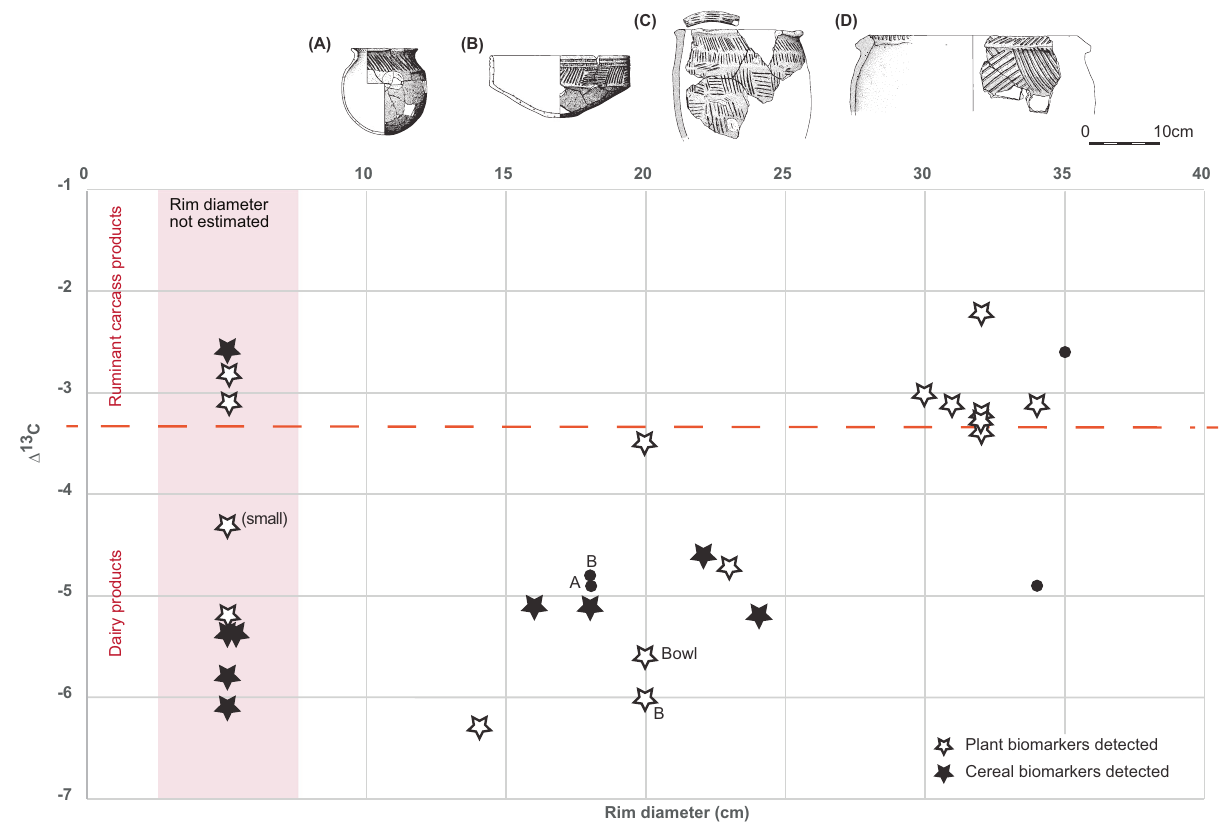
Fig. 6 | Plot showing the Δ 13 C ( δ 13 C 18:0 – δ 13 C 16:0 ) value of the fatty acids from degraded animal fats plotted against rim diameters of Neolithic pots, where possibletoestimate. Datapointsshownasstarsdenotetheadditionalobservation of plant-derived markers in the organic residue, whilst a fi lled star denotes the presence of diagnostic cereal-derived markers. The dashed line shows the